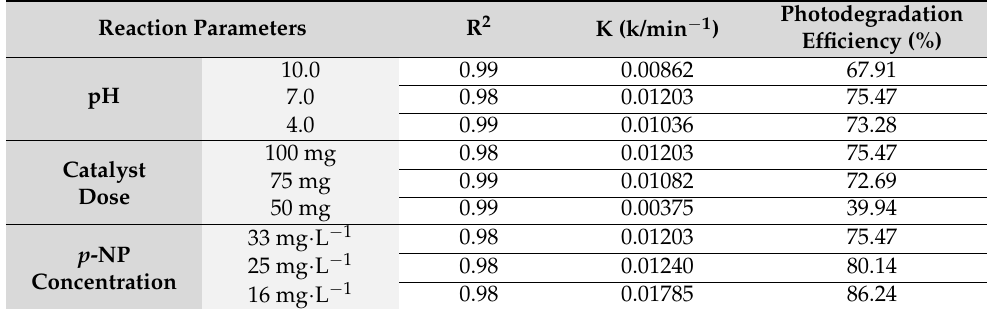
Figure 9. ( A ) Effect of pH on degradation of p -NP on Ag-4 catalyst under visible light, ( B ) Effect of dose of Ag-4 catalyst on degradation of p − NP under visible light, ( C ) Effect of p − NP concentration on Ag-4 catalyst degradation efficiency under visible light. Table 2. Degradation efficiency, correlation coefficients (R), and rate constants (K) of p -NP degradation at different